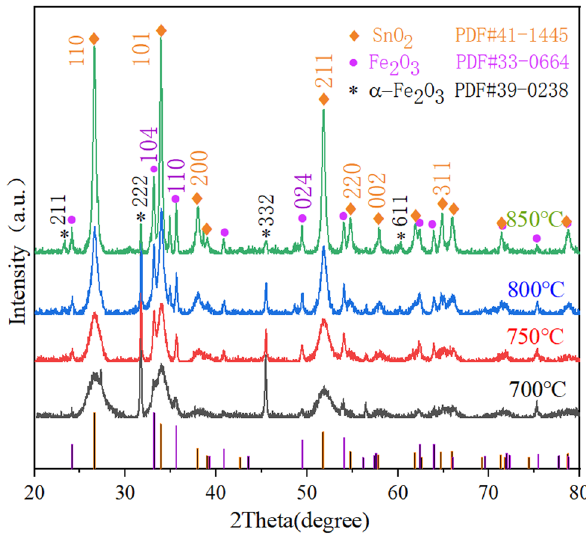
Figure 1: XRD spectrum of the Fe – Sn – O catalyst at di ff erent calci - nation temperatures of 700°C, 750°C, 800°C, and 850°C.